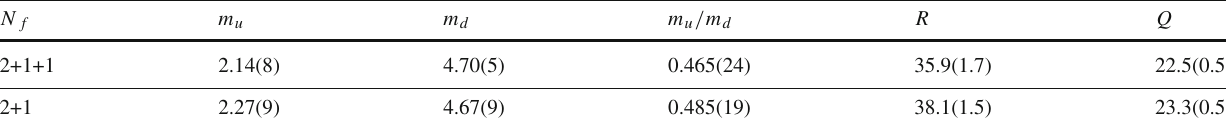
Table 11 Our estimates for the masses of the two lightest quarks and related, strong isospin-breaking ratios. Again, the masses refer to the MS scheme at running scale μ = 2GeV. Mass values are given in